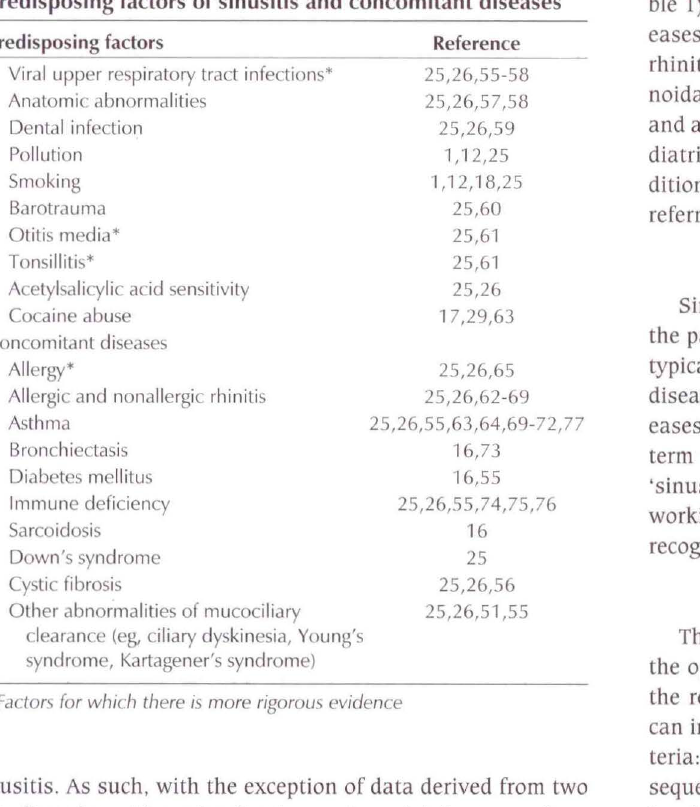
Predisposing factors of sinusitis and concomitant diseases